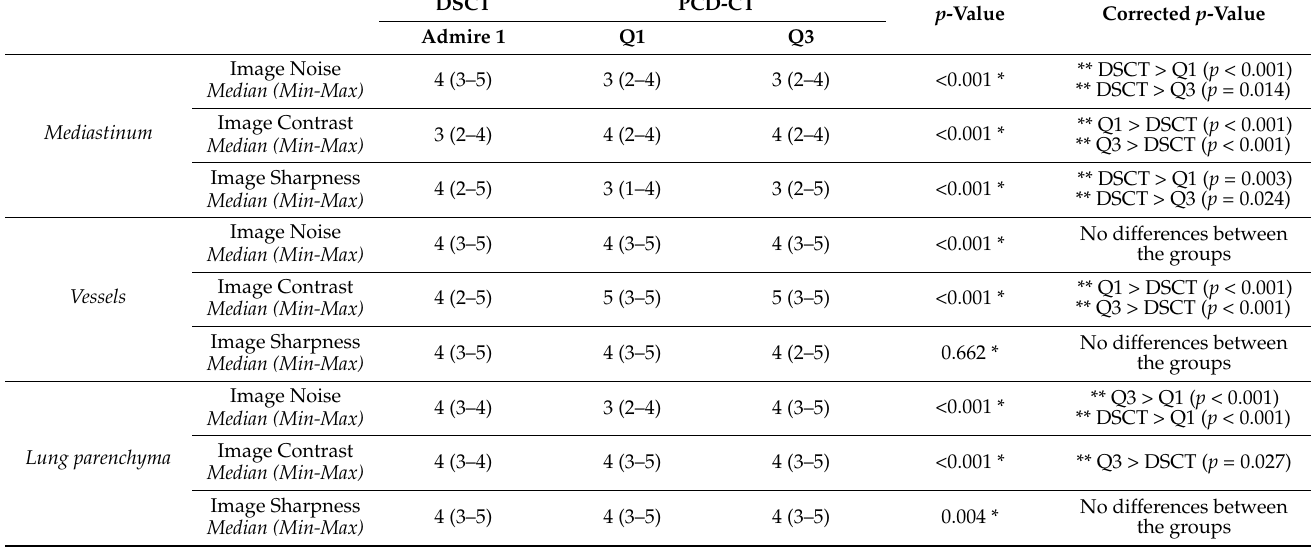
Figure 5. Coronal reformats of a contrast-enhanced chest-CT in a 76-year-old female patient. Note the different quality in delineation of intercostal vessels. ( A , C ): Window width: 877 HU, Window level: 108 HU, ( B , D ): Window width: 342 HU, Window level: 56 HU, ( A , B ) Q1 iterative reconstructed image data set, ( C , D ) ADMIRE1 iterative reconstructed image data set. Arrows: thin intercostal vessels. The Q1 strength of the PCD-CT was associated with a higher noise level in the medi- astinum, vessels, or lung parenchyma compared to the equivalent DSCT images (Table 4). Lung parenchyma sharpness was significantly higher in Q3 level reconstructed PCD-CT images than the DSCT images ( p = 0.027). Table 4. Comparison of the subjective image quality between the DSDECT and PCD-CT (Q1 and Q3). DSCT PCD-CT p -Value Corrected p -Value Admire 1